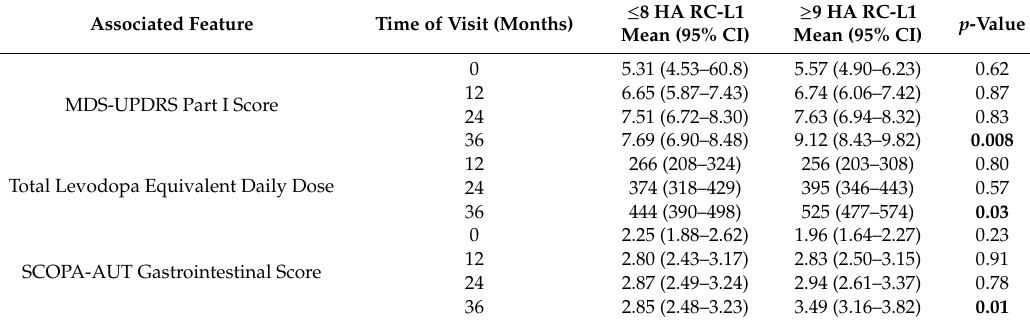
Table 2. Clinical features of Parkinson’s disease that were significantly associated with di ff erent numbers of HA RC-L1. The mean and 95% confidence intervals (CI) are reported for each feature that were significantly di ff erent between PD subjects with ≤ 8 HA RC-L1s compared to those with ≥ 9. Associated Feature Time of Visit